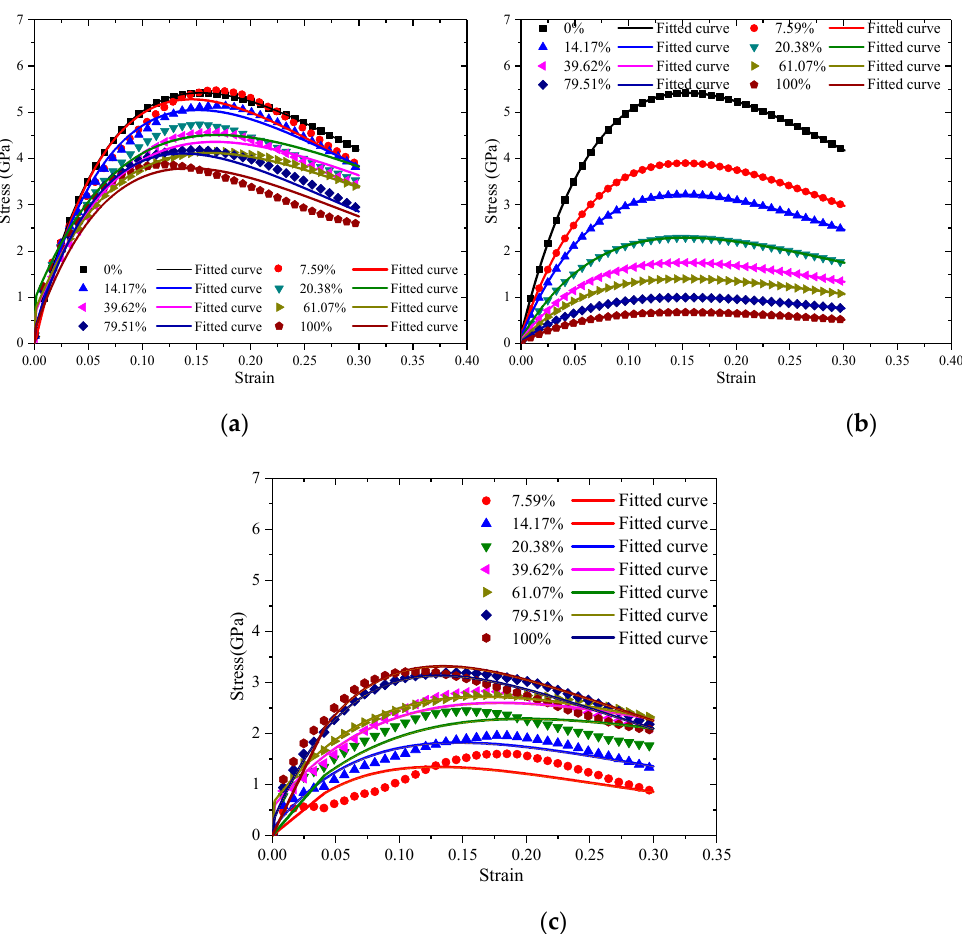
Figure 6. Under the strain rate at 0.8 ps − 1 , decomposition and fitting of stress-strain relationship curves for the effect of water on the mechanical properties: ( a ) Total effect of water; ( b ) Effect of water on C–S–H matrix; ( c ) Interaction between water molecules and C–S–H matrix.